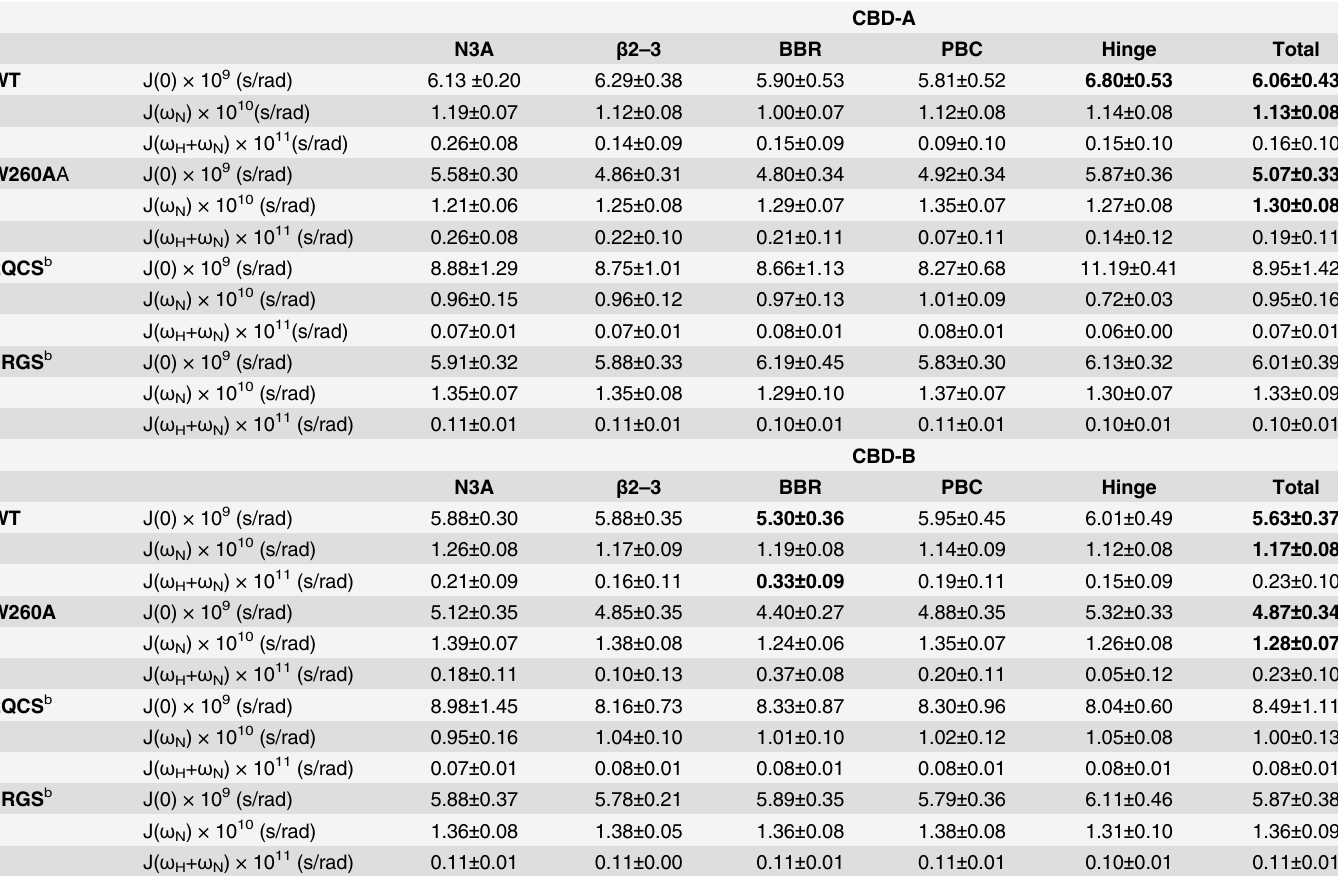
Table 1. Spectral density mapping statistics a , b